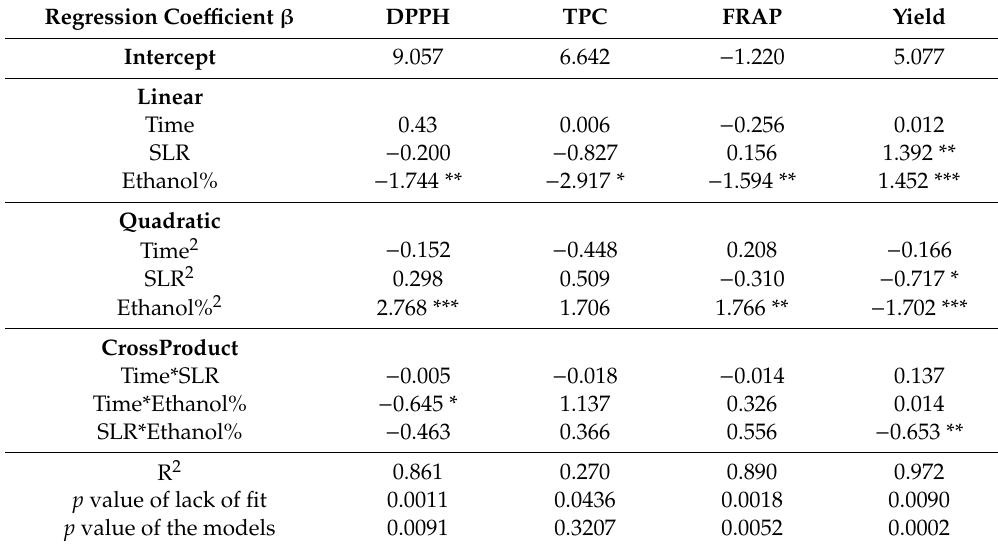
Table 1. Regression coe ffi cients for the developed response surface model. *, ** and *** indicate parameter significance to the corresponding response, with p < 0.05; 0.01 and 0.001